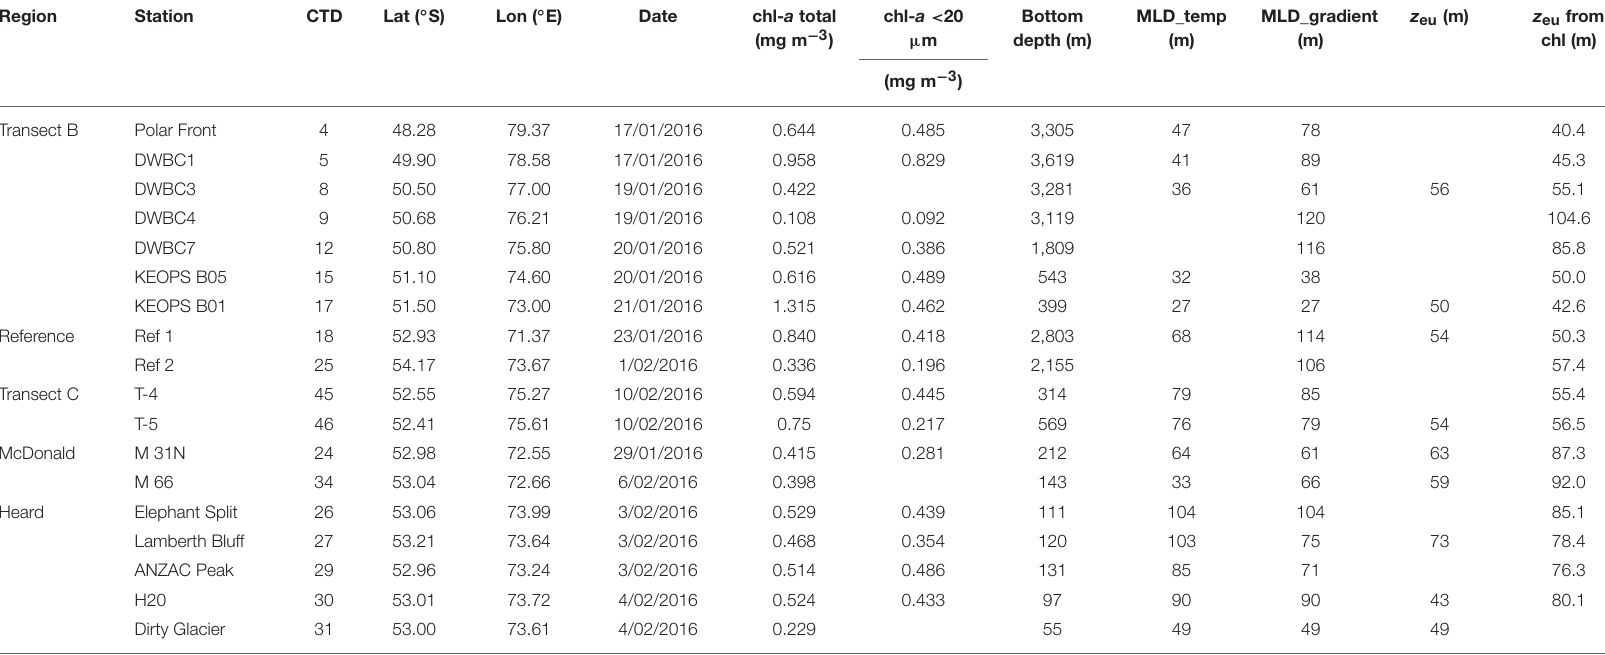
TABLE 2 | Sampling stations during the HEOBI